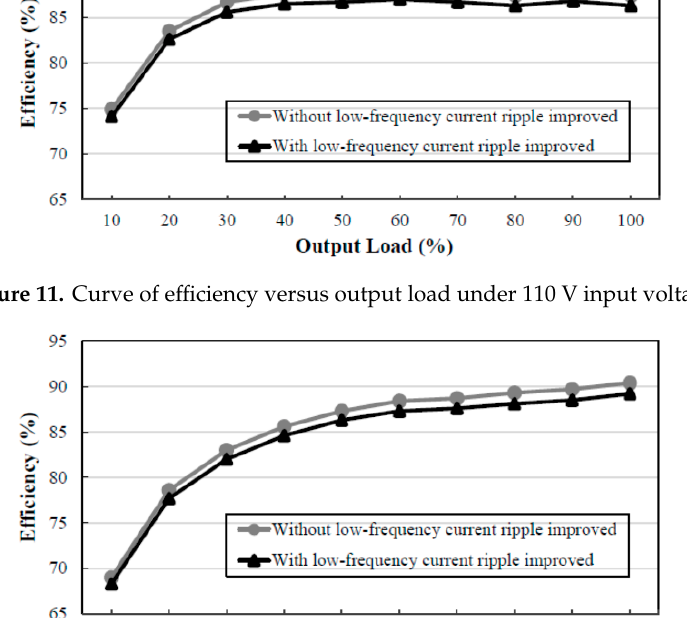
Figure 13. Curve of power factor versus output load under 110 V input voltage. Figure 14. Curve of power factor versus output load under 220 V input voltage. 5.4.3. Total Harmonic Distortion Comparison Figure 15 shows curves of total harmonic distortion versus output load without and with the low-frequency current ripple improved at the input voltage of 110 V, whereas Figure 16 shows the curves of total harmonic distortion versus output load without and with the low-frequency current ripple improved at the input voltage of 220 V. From these two figures, the total harmonic distortion with the low-frequency current ripple improved is slightly lower than that without the low-frequency